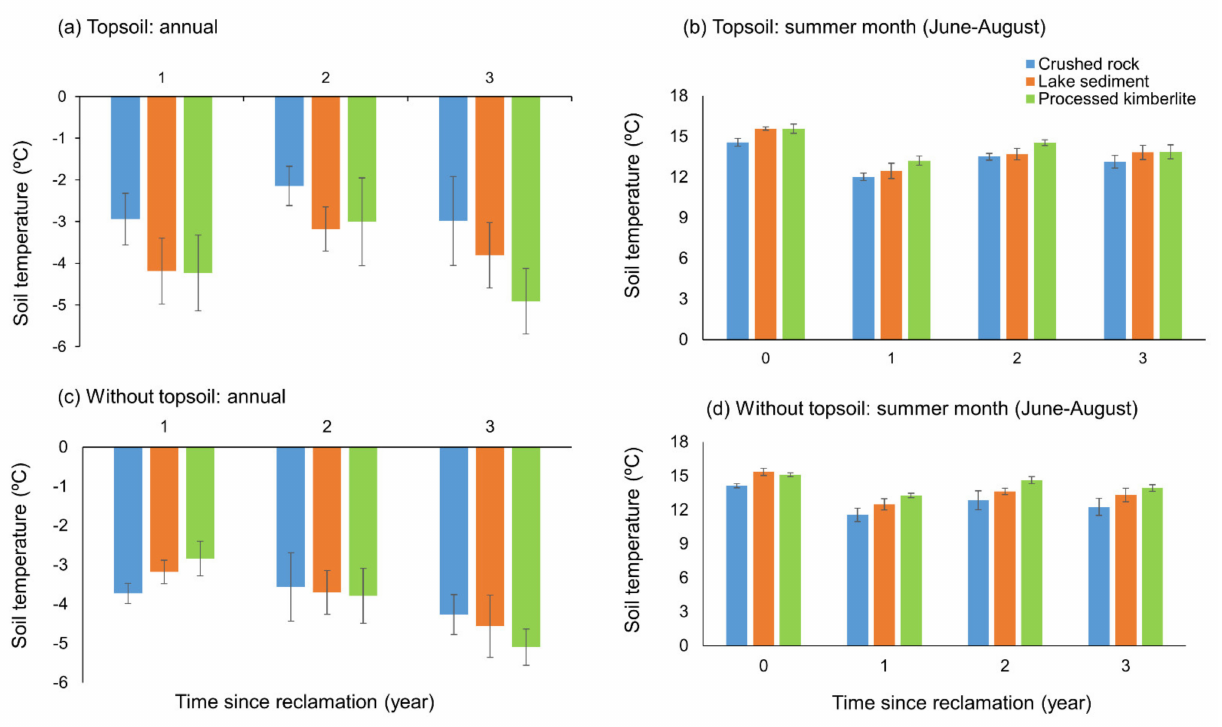
Figure 7. ( a – d ) Mean annual and summer month soil temperature by topsoil treatments and sub- strates at the research